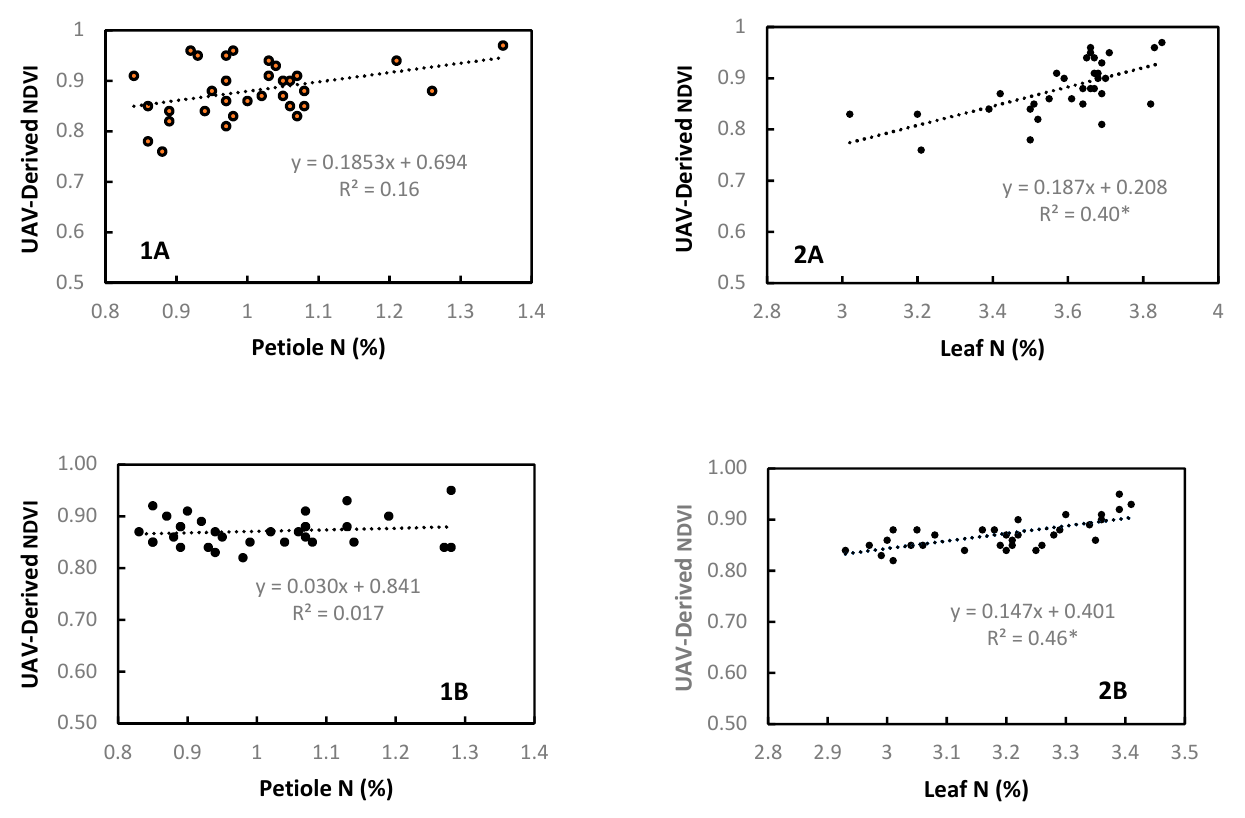
Figure 1. Relationship between petiole (1) and leaf (2) N and UAV-based NDVI at site A and B in 2016. *significant at p = 0.05. Similar results found in 2015 (site A, data not shown).